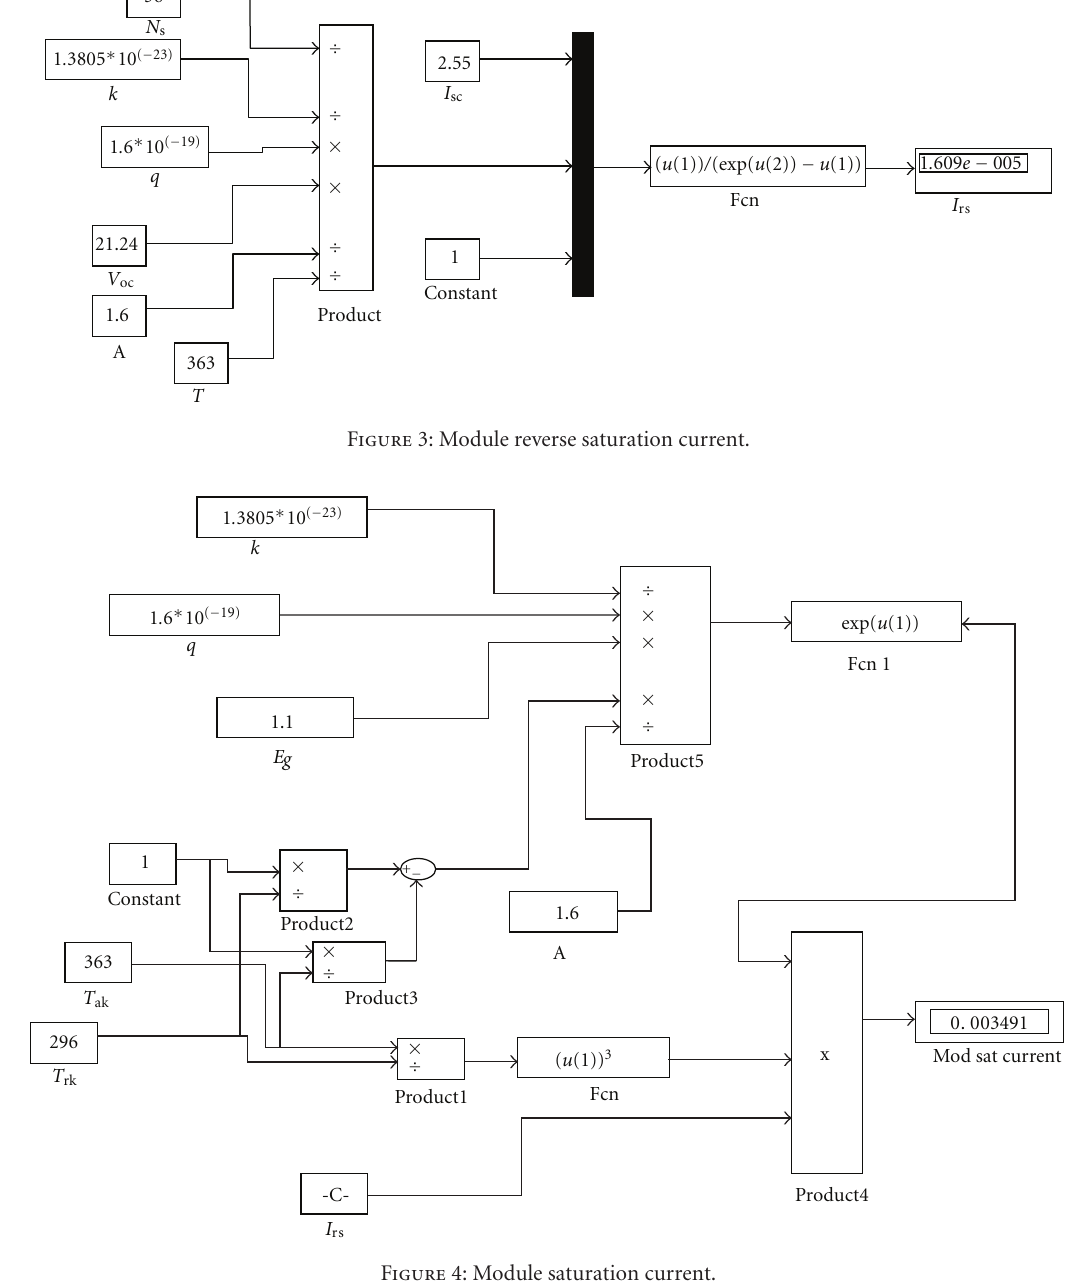
Figure 4: Module saturation current. Table 1: I ph for various insolations and